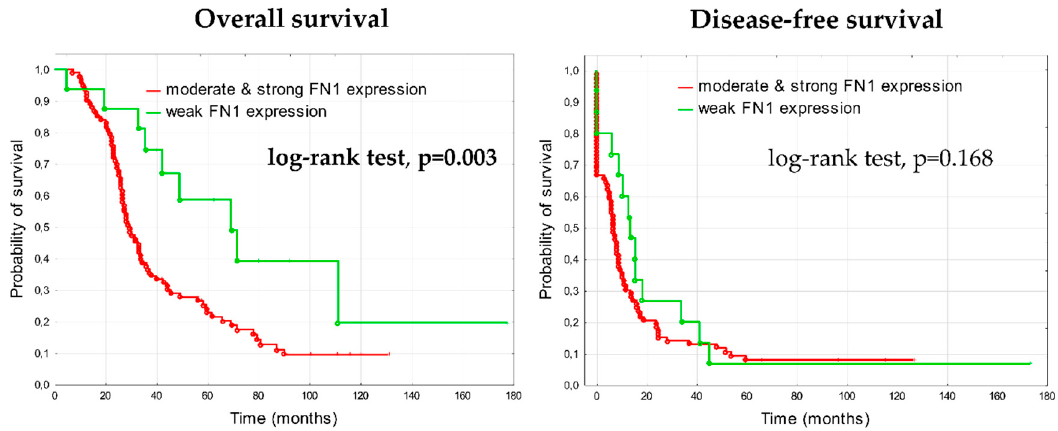
Figure 3. Kaplan-Meier analysis of overall survival and disease-free survival in 108 patients with advanced ovarian cancers stratified by stronger fibronectin expression (score 2 & 3) versus weak fibronectin expression (score 1) in the tumor stroma.